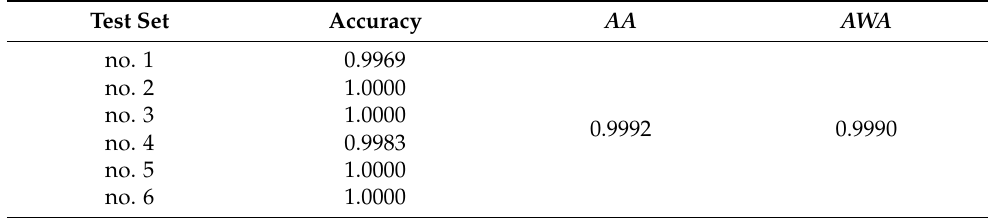
Table 4. Cross − validation accuracy for different folds, and overall AA and AWA